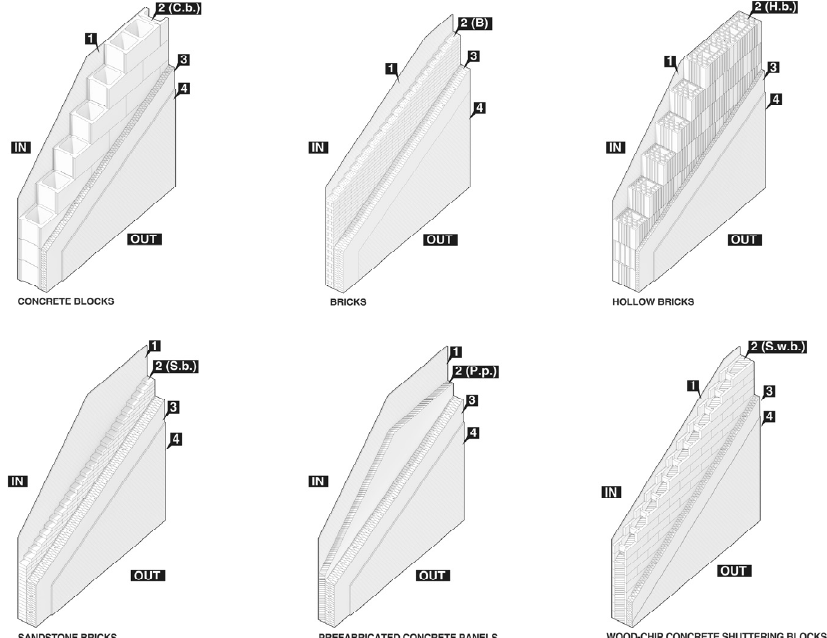
Figure 8. Wall types represented by stratigraphy that includes: 1 = Internal plaster; 2 = Wall building material (C.b. = Concrete block; B. = Bricks; H.b. = Hollow bricks; S.b. = Sandstone bricks; S.w.b. = Shuttering wood chips blocks; P.p. = Prefabricate concrete panels); 3 = Thermal insulation (EPS); 4 = External plaster.